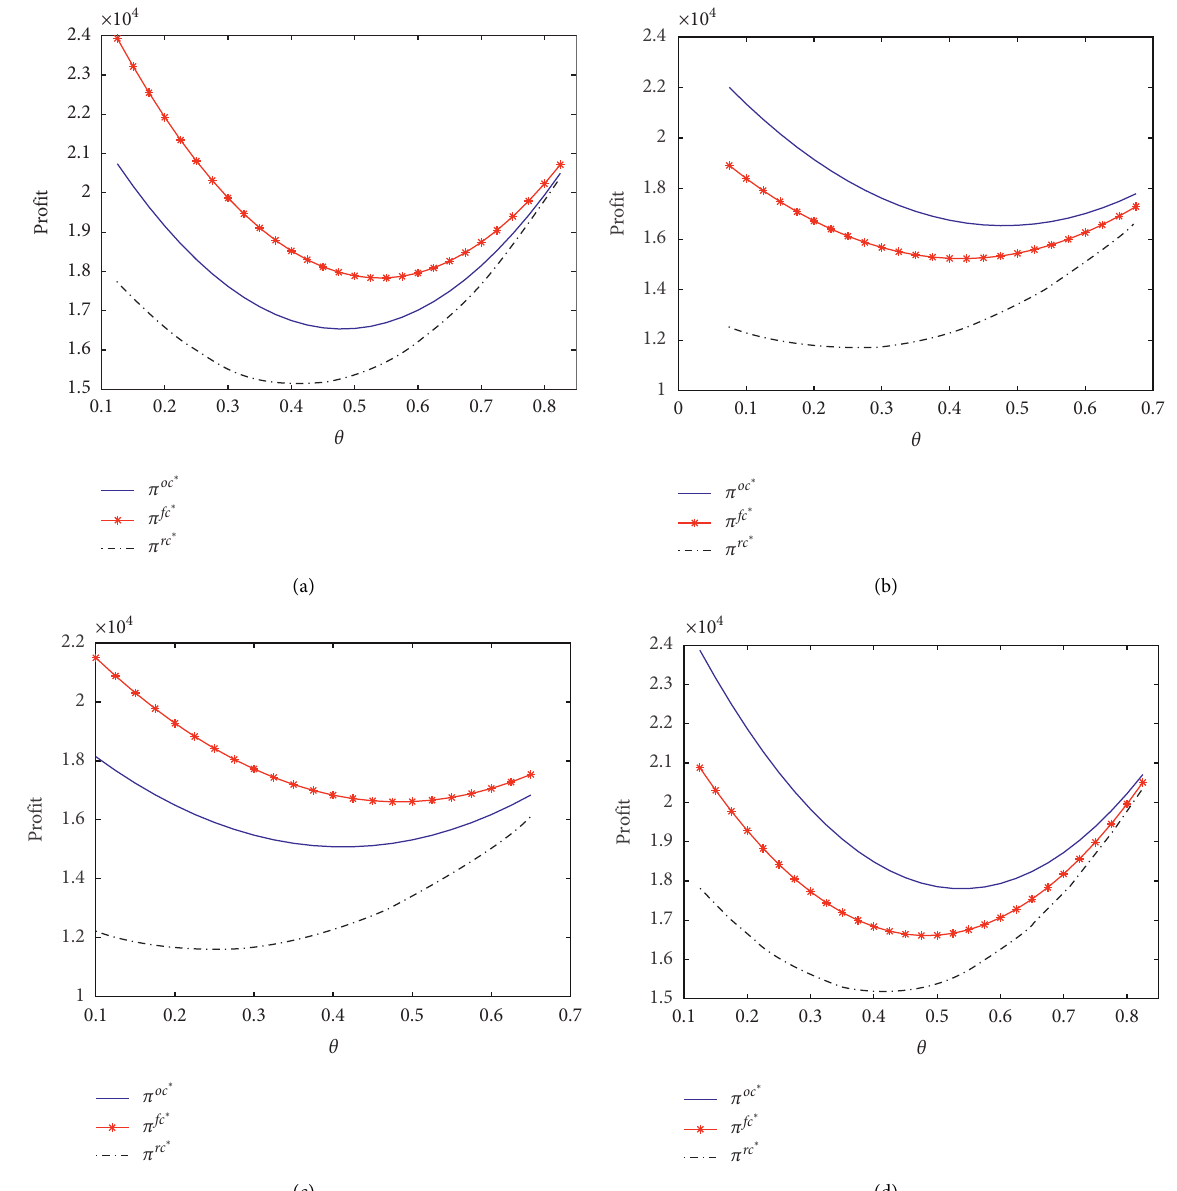
Figure 6: Effect of v and w on the DCR’s system profit. (a) r � 0 . 2, v � 0 . 1, and w � 0 . 2, (b) r � 0 . 2, v � 0 . 3, and w � 0 . 2, (c) r � 0 . 2, v � 0 . 2, and w � 0 . 3, and (d) r � 0 . 2, v � 0 . 2, and w � 0 .